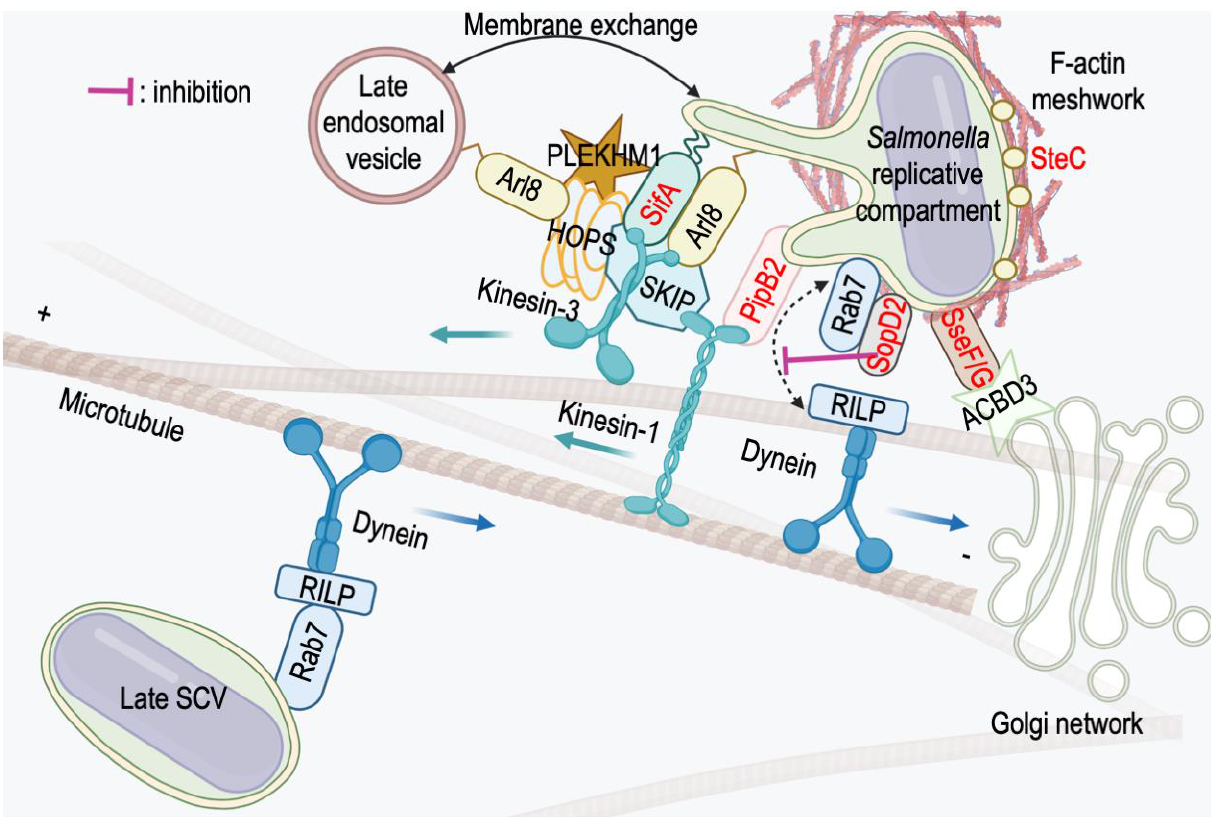
FIGURE 3: Salmonella effectors and host proteins interactions . The small GTPase Rab7 is acquired during the maturation phase of the SCV and its presence is persistent thereafter. Its association with RILP allows the recruitment of dynein and the retrograde movement of the maturing Late SCV to the juxtanuclear region. Specific T3SS-2 effectors (in red) are localized on the replicative compartment. The presence of SopD2 maintains Rab7 in a GDP-bound form that does not bind RILP and prevents dynein recruitment. SteC has a kinase activity neces- sary for actin polymerization in the vicinity of SCVs/SITs. SseF/G anchor the SCV to the Golgi network via an interaction with the Golgi resi- dent protein ACBD3. Both PipB2 and SifA recruit kinesin-1, respectively through a direct interaction or via SKIP. Kinesin-3 is recruited through its interaction with SifA and SKIP. SifA recruits the small GTPase Arl8 and these proteins are bound to the membrane by geranyl- geranylation or acetylation, respectively. SKIP and PLEKHM1 compete to bind to SifA and Arl8 and both recruit the HOPS tethering complex on SCVs/SITs to initiate the fusion process with the late membrane compartments of the host